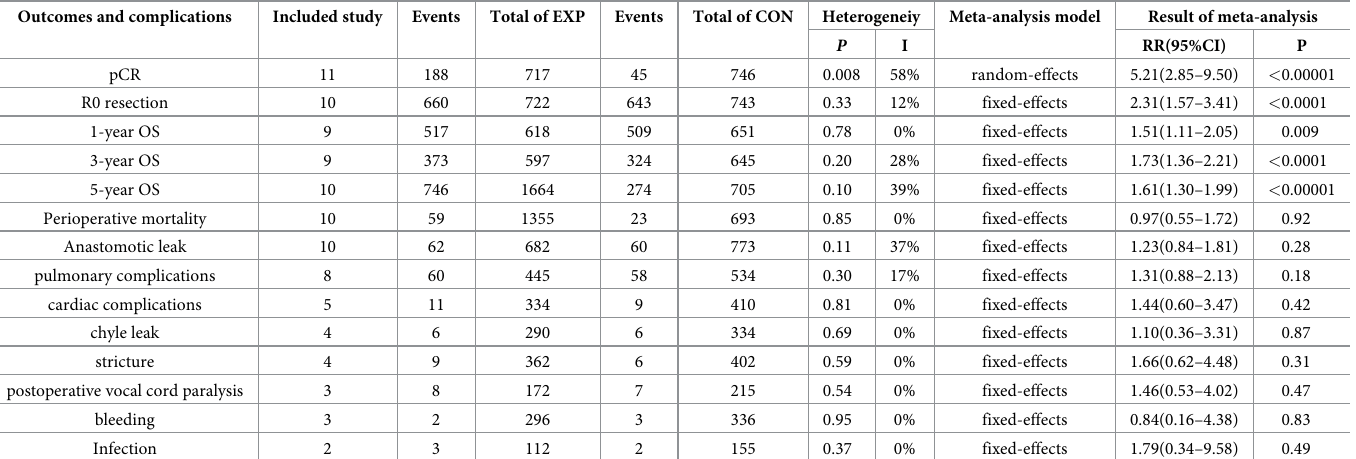
Table 2. Summary of the results of